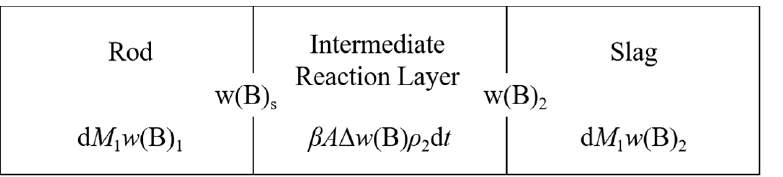
Figure 3. Distribution of component (B) in each phase during the dissolution of the rod with Ti inclusions.